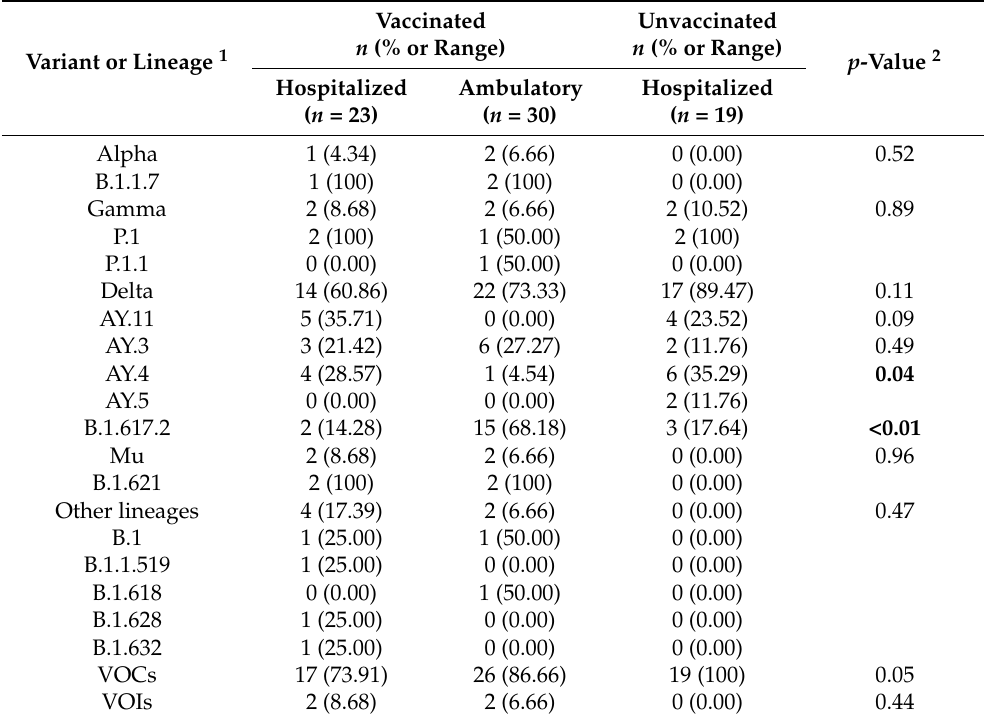
Table 2. Descriptive data of SARS-CoV-2 variants and lineages detected in this